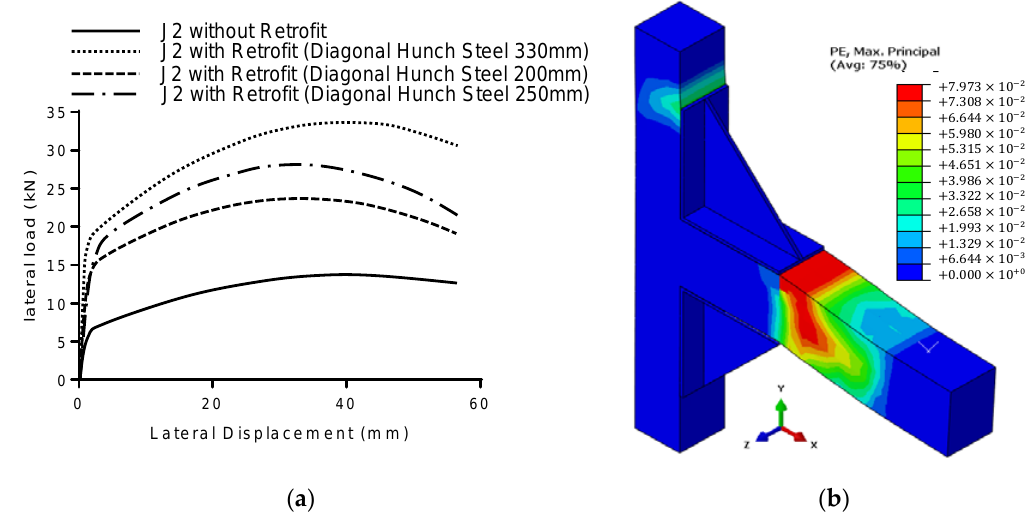
Figure 16. Ultimate resistance and damage of retrofitted joint J2. ( a ) Joint resistance based on haunch dimension. ( b ) Damage of retrofitted joint.